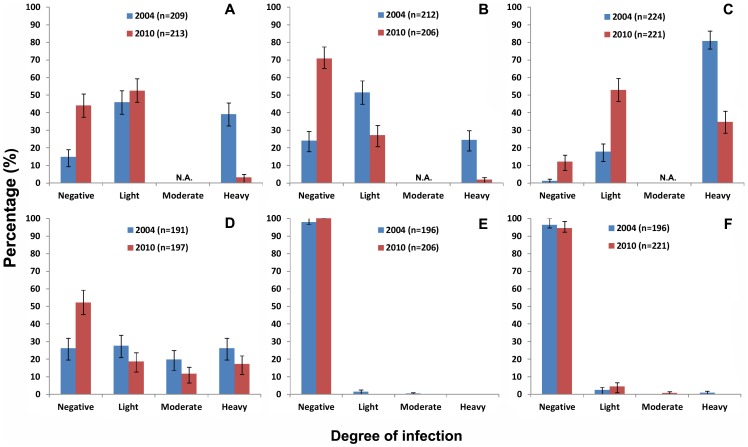
Percentage proportion of light, moderate or heavy infections in 2004 and 2010.Upper panel: S. haematobium infection in Macina (A), San (B) and Segou (C), categorized as light (<50 eggs/10 ml of urine) and heavy (≥50 eggs/10 ml of urine) infections. Lower panel: S. mansoni infection in Macina (D), San (E) and Segou (F), categorized as light (1–99 epg), moderate (100–399 epg) and heavy (≥400 epg) infections. N.A.: not applicable. Error bars represent the 95% CI.